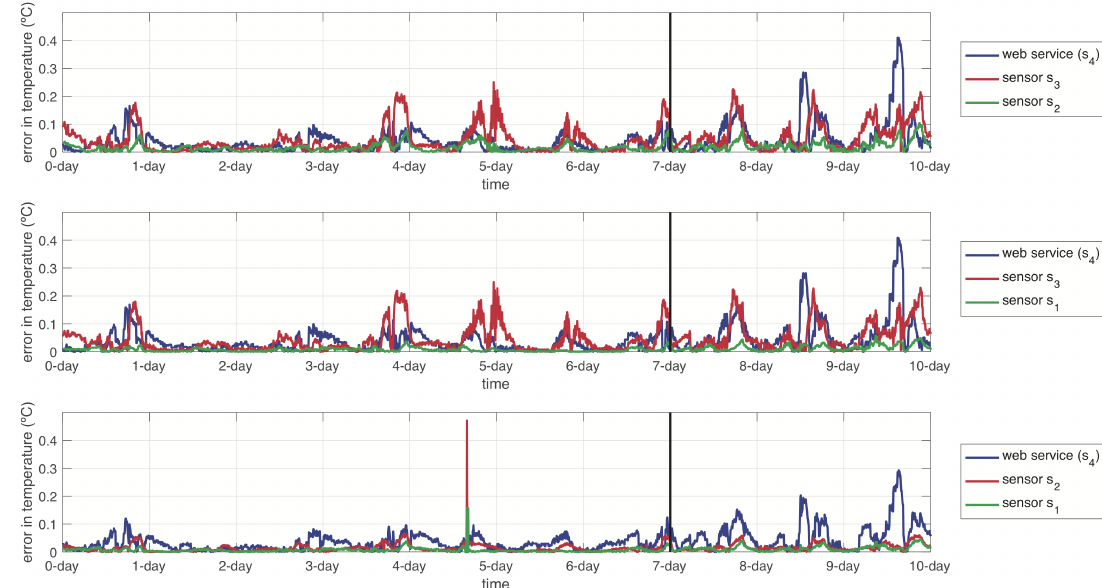
Figure 14. Absolute error between the dynamic function estimations associated to each sensor node s 1 , s 2 and s 3 in comparison with the actual values. Left side of the vertical line refers to training data and right side refers to the testing data.